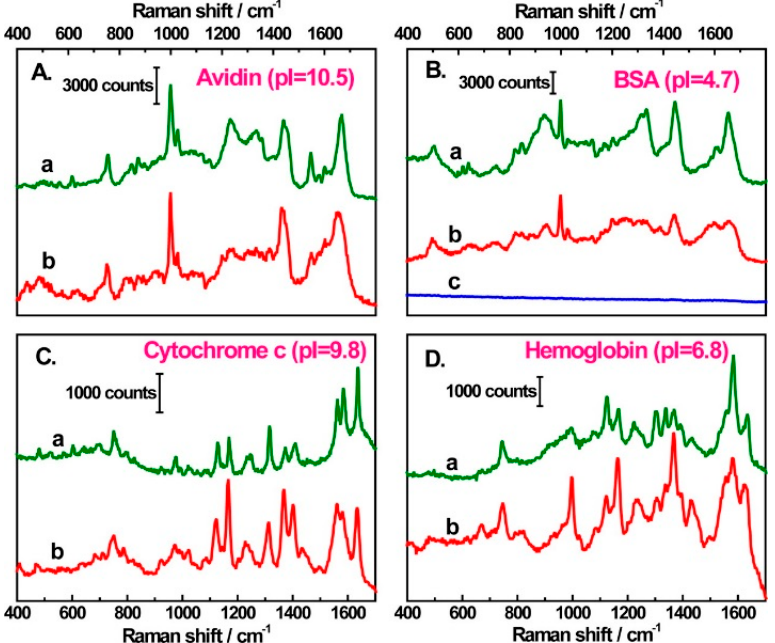
Figure 52. Comparison of the normal Raman (green line, a) and amplified SERS spectra (red line, b) of Avidin ( A ), BSA ( B ), Cytochromo c ( C ), and Hemoglobin ( D ). SERS spectra are obtained with the iodide-modified Ag nanoparticles method, using sample concentrations of 300, 300, 3, 30 μ g/mL, respectively, aggregated by MgSO4. The blue line c, in BSA spectra ( B ), evidence the aggregation effect: No Raman signal is detected before aggregation. Raman spectra of avidin, BSA, and Hemoglobin solid are obtained with 20 mW laser power and 30 s acquisition time. Reproduced with permission from Xu et al. [465]. Copyright (2014), the American Chemical Society.